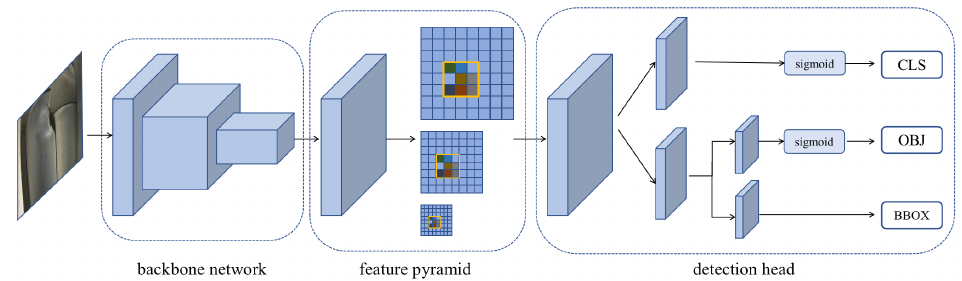
Figure 1. The structure of the YOLOX target detection